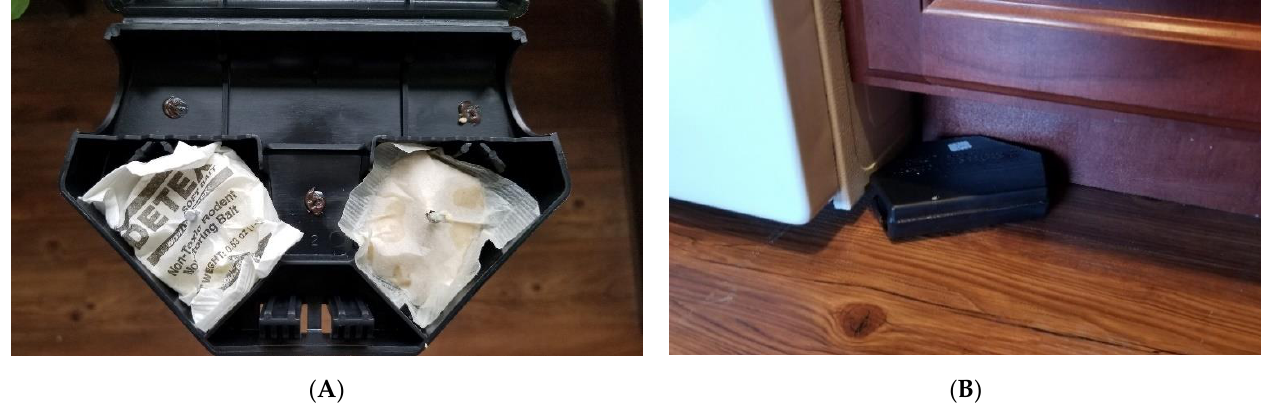
Figure 1. Protecta ® EVO ® Mouse bait stations for detecting house mouse activities. ( A ) An opened bait station showing non-toxic baits (Left: Detex ® soft bait; Right: Liphatech ® Rat & Mouse Attractant) and three dollops of chocolate spread. ( B ) A bait station placed beside the stove in a kitchen.